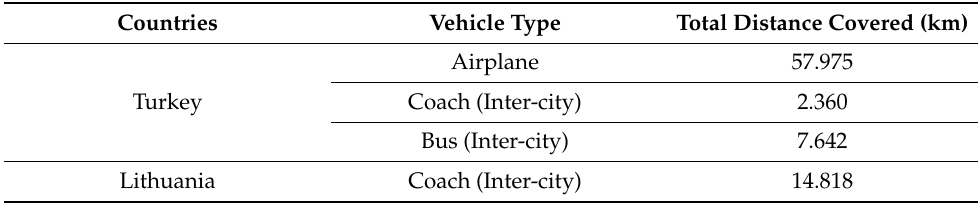
Table 1. The types of vehicles preferred and the distances covered by the teams in the Turkish Ice Hockey Intercity Super